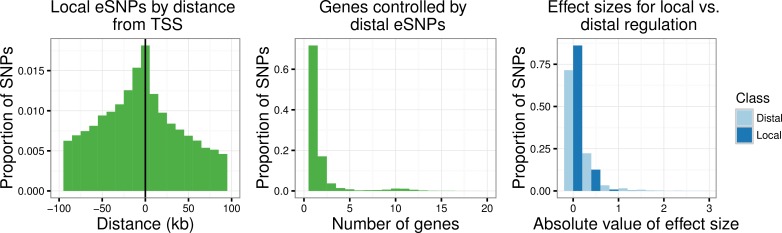
Characteristics of local and distal eSNPs.Position of local eSNPs relative to transcription start site (TSS) of the gene queried by the associated probe (left). Number of genes controlled by distal eSNPs (center), excluding SNP kgp22834062, which was associated to 129 genes. Effect sizes (absolute values of the regression coefficients) of the most significant SNP for each probe with any local or distal associations (right).